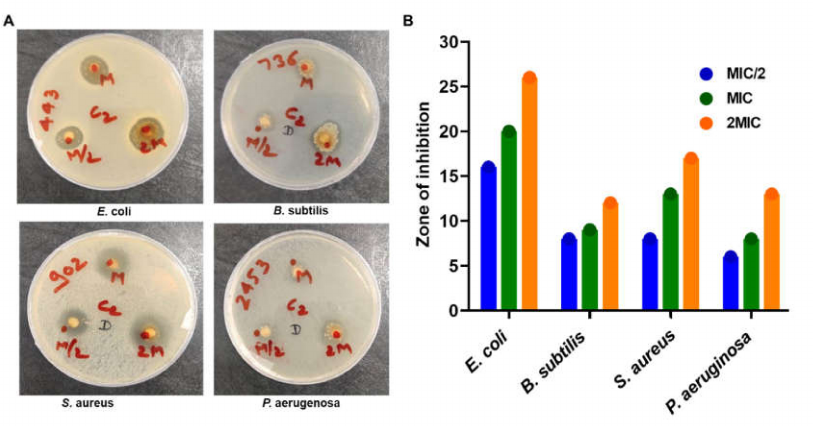
Figure 2. Zone of inhibition assay. ( A ) Representative images of culture plates showing PIP mediated growth inhibition of Bacillus subtilis , E. coli, Staphylococcus aureus , and Pseudomonas aeruginosa . ( B ) Quantifica- tion of ZOI studies for Bacillus subtilis , E. coli, Staphylococcus aureus , and Pseudomonas aeruginosa . Table 2. Zone of inhibition (in mm) as measured around the disk of various concentrations of